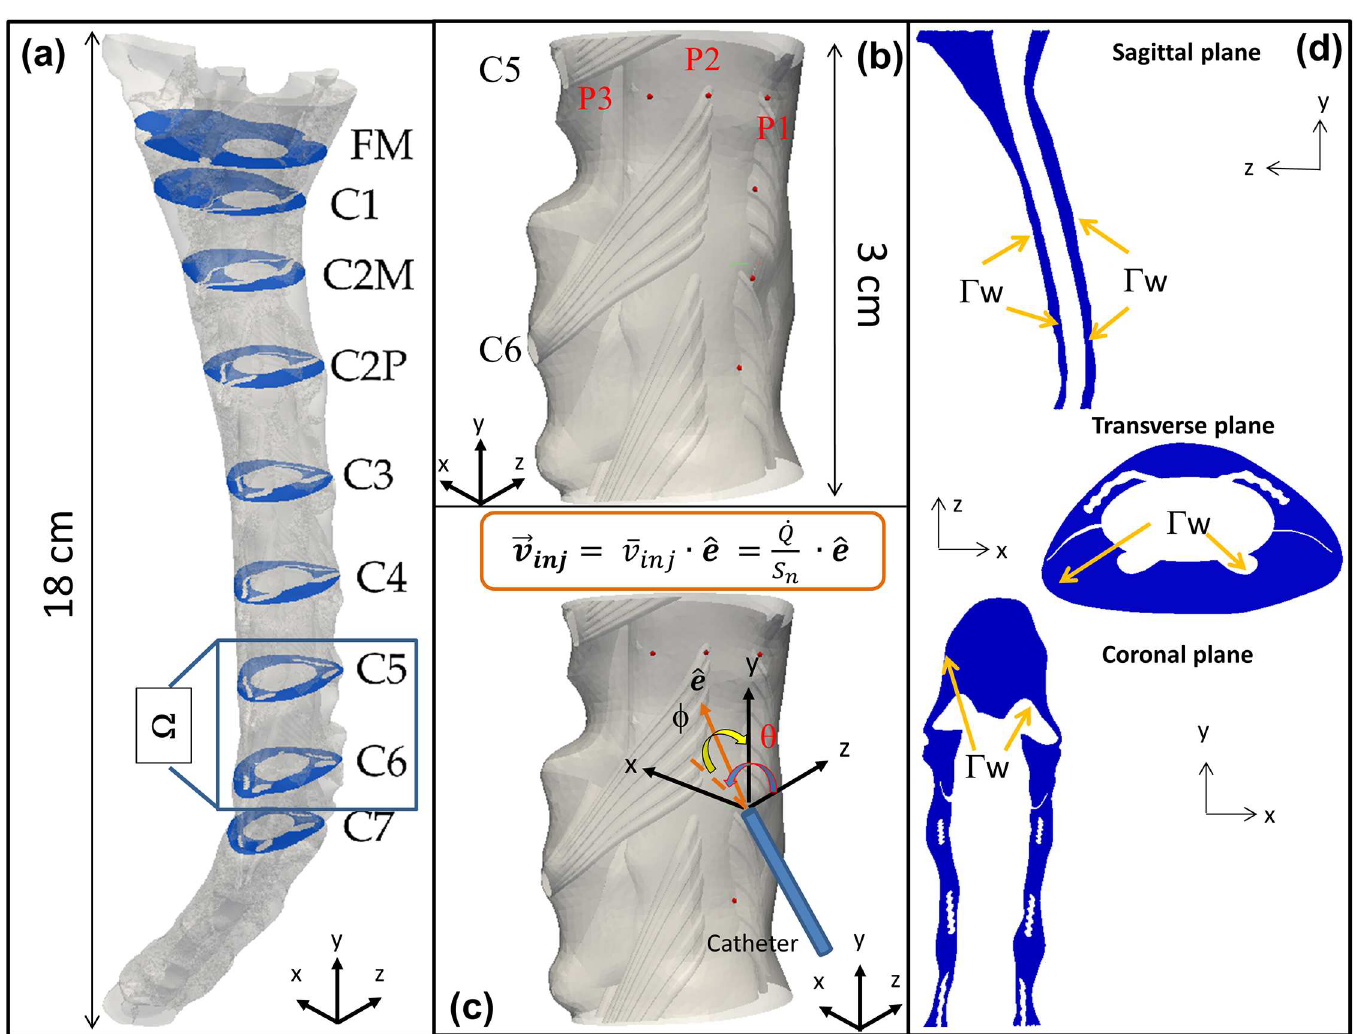
Fig 1. Geometry of the anatomical domain. (a) 3D geometry of the cervical SAS with NRDL also showingrelevant anatomicalcross sections; (b) Injection positions;(c) Sphericalsystem to define catheter angle; (d) Illustrative sections of the cervical SAS: sagittal (x = 1.7 cm), transverse (y = 6 cm) and coronal (z = 0.85